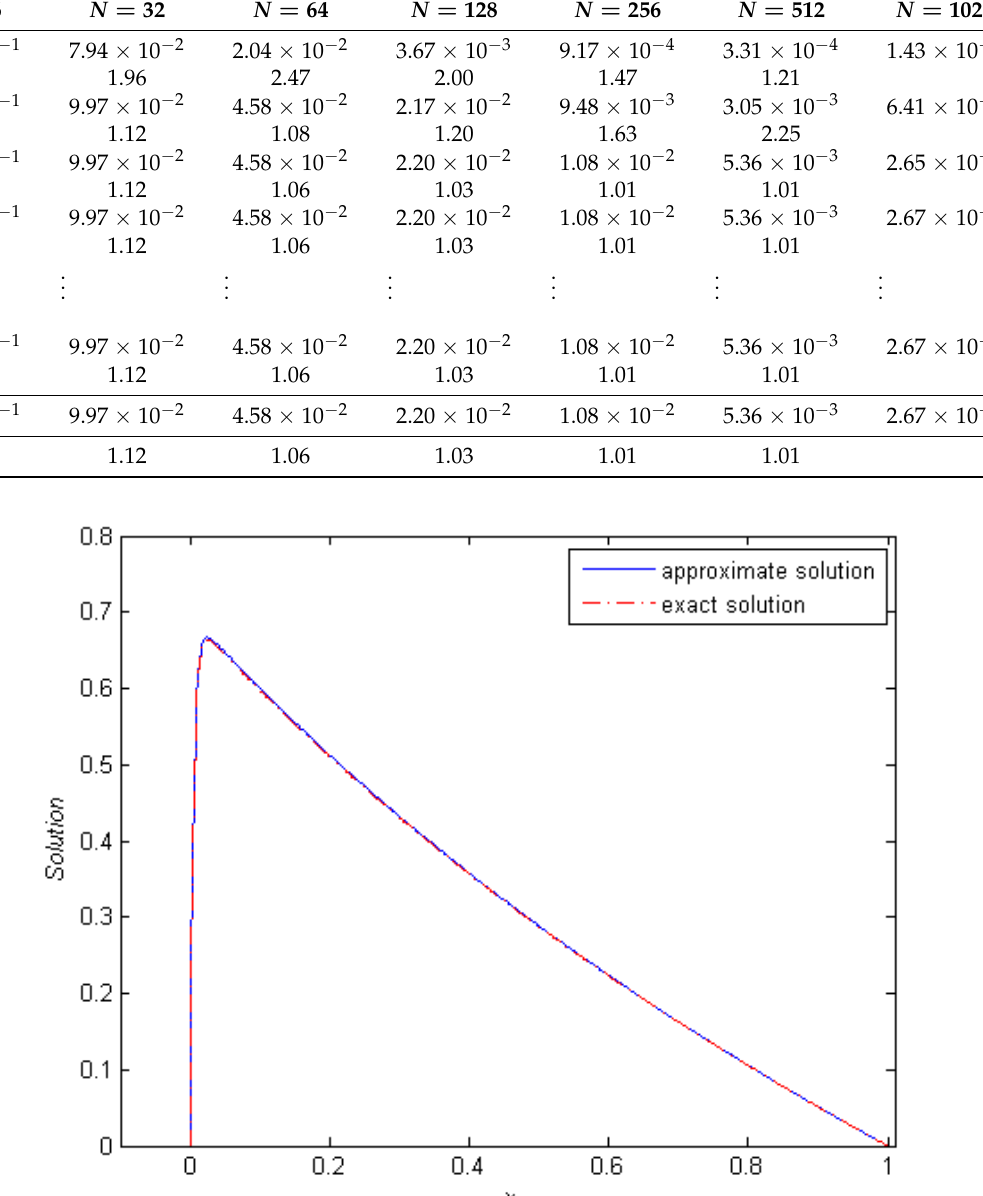
Figure 1. Comparison of the exact and approximate solutions of Example 1 for ε = 10 − 2 and N =